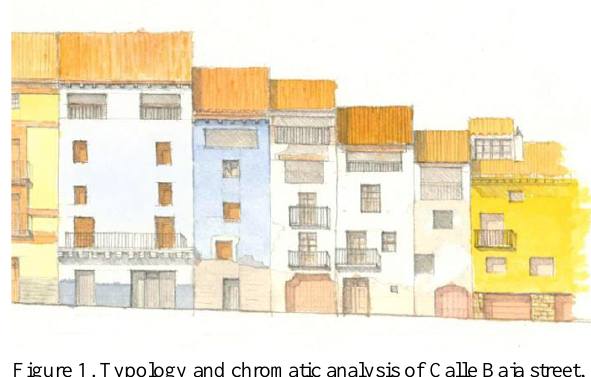
Figure 1. Typology and chromatic analysis of Calle Baja street, in Albalate del Arzobispo (Gil Bordás, 2016).